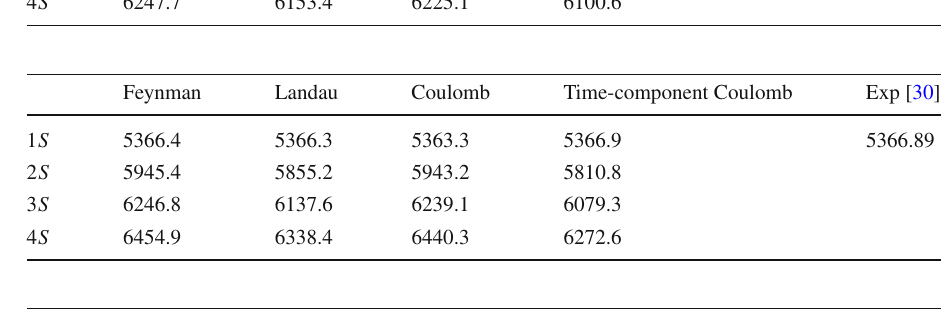
Table 5 Mass spectra of B